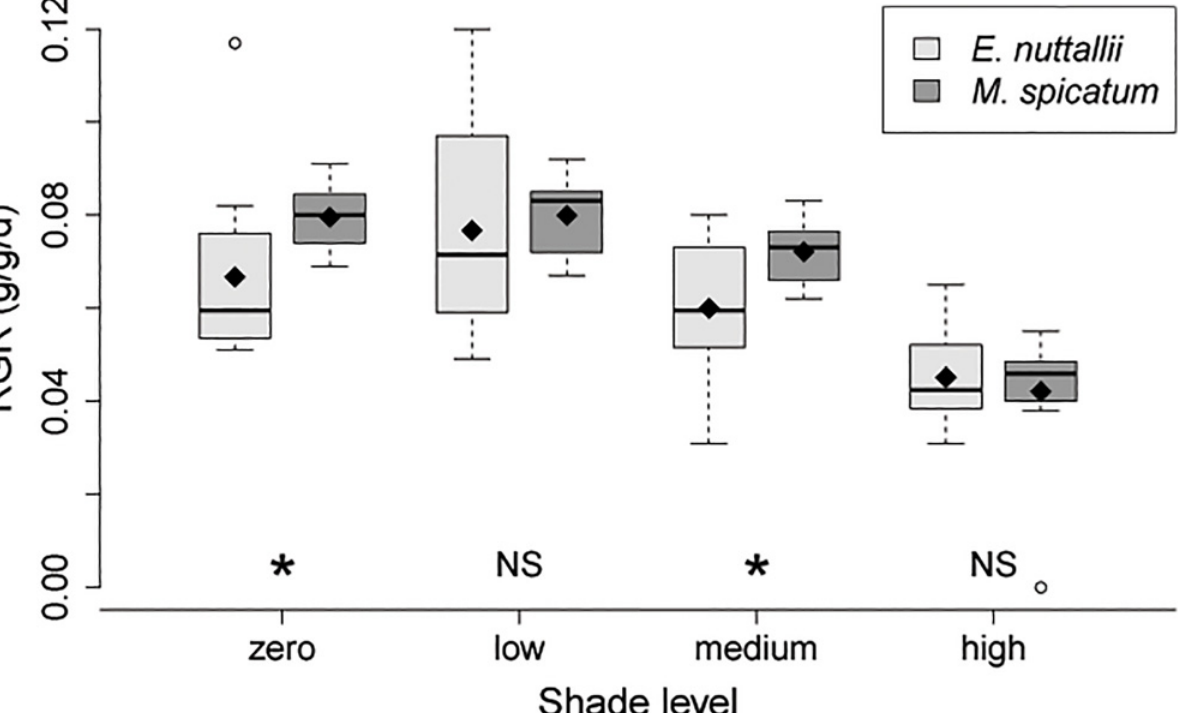
Fig 2. Boxplots comparing RGR of M . spicatum and E . nuttallii planted concurrently across shade levels. Box edges mark the 1st and 3 rd quartile, and the median is shown with a dark line. Whiskers extend to a maximum of 1.5 x interquartile range outward, and values beyond this are indicated by circles. Diamonds show the mean of each shade level * species combination. Asterisks indicate significant differences (p < 0.05) in pairwise t-tests between species, and “ NS ” indicates non-significant differences.